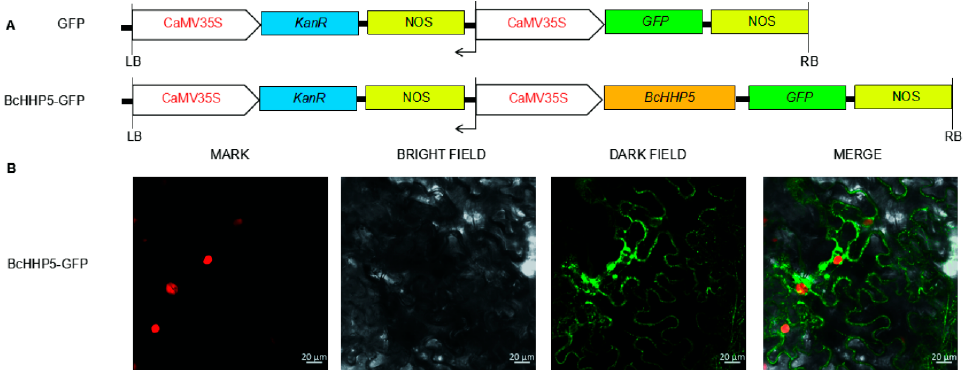
Figure 6. Localization analysis of the BcHHP5 protein. ( A ) Schematic representation of the construction of 35S: GFP and 35S: BcHHP5-GFP ; ( B ) schematic representation of the transient expression of 35S: GFP and 35S: BcHHP5-GFP fusion proteins in tobacco leaves (20 µ m